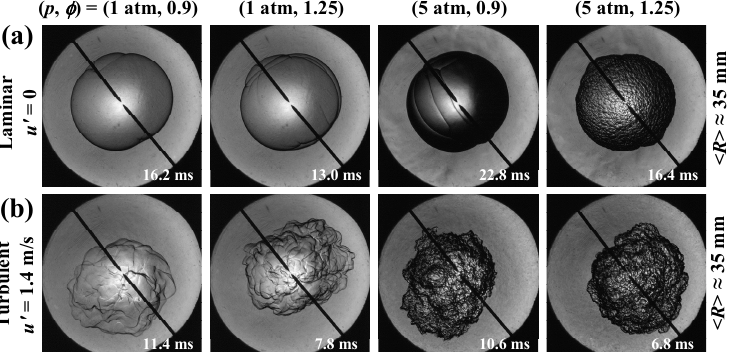
increases with pressure because ν ∼ ρ −1 ∼ p −1 . All images in both ( a ) laminar and ( b ) turbulent cases have the same  R  ≈ 35mm in the same view field of 110 mm × 110 mm for comparison.